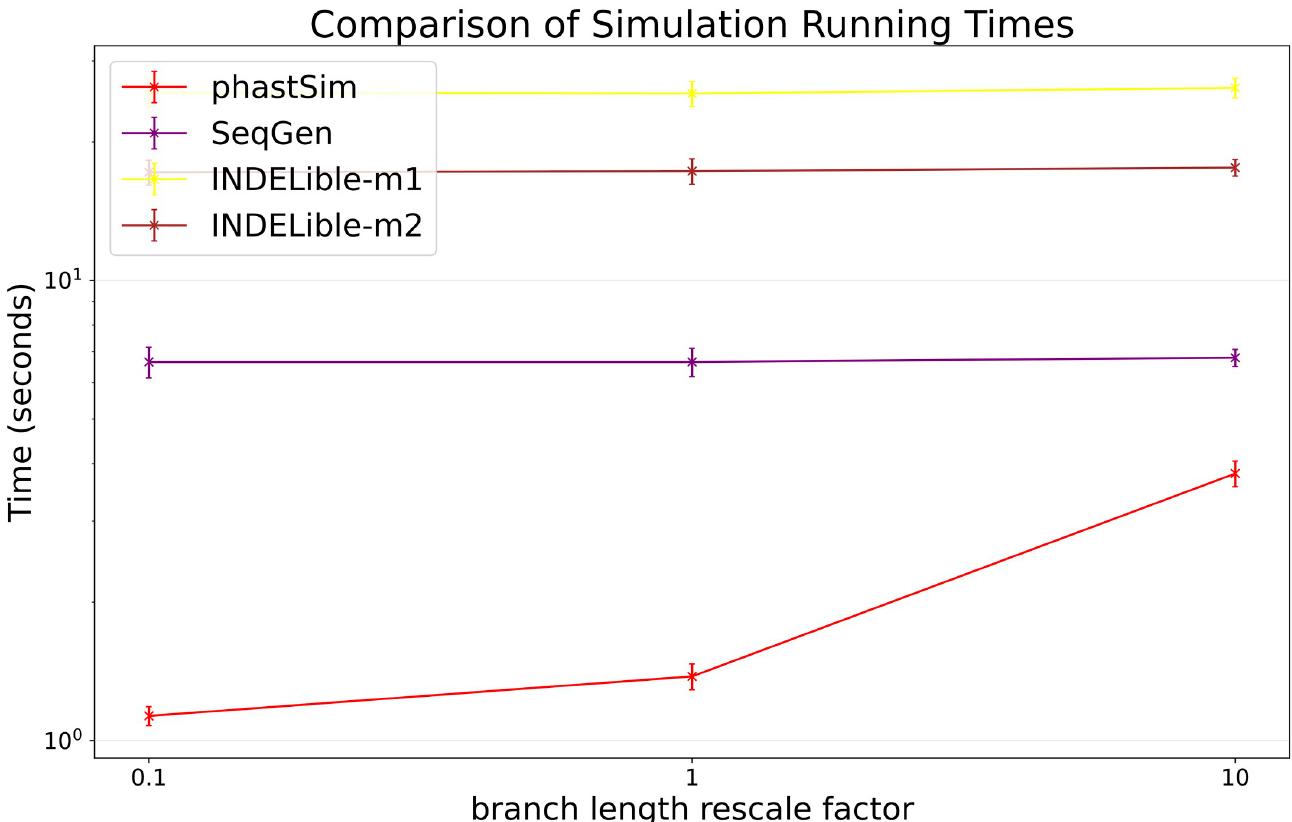
Fig 7. Comparison of running times of different simulators in a SARS-CoV-2 scenario after rescaling the tree branch lengths by different factors. On the Y axis we show the number of seconds it takes to perform simulations using different software. On the X axis is the rescaling factor we use to make the phylogenetic tree branch lengths longer or shorter. Colors are as in Fig 3. Here we used alignments of 5000 tips.